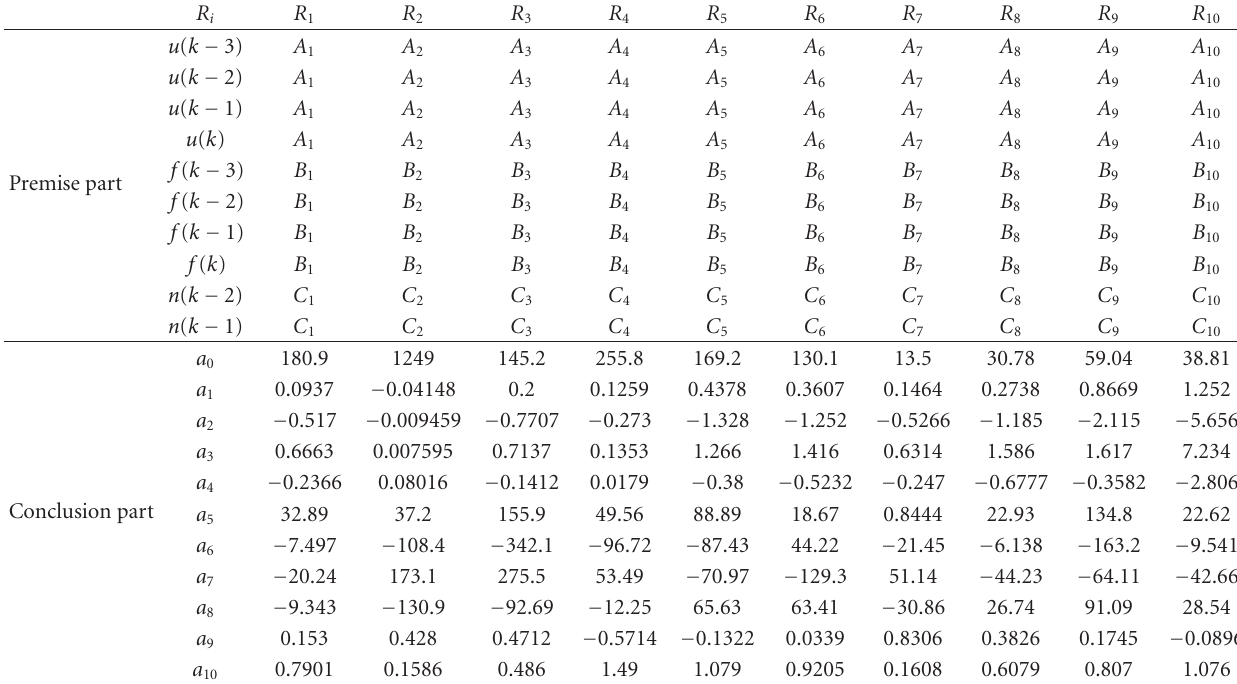
Table 3: Final fuzzy